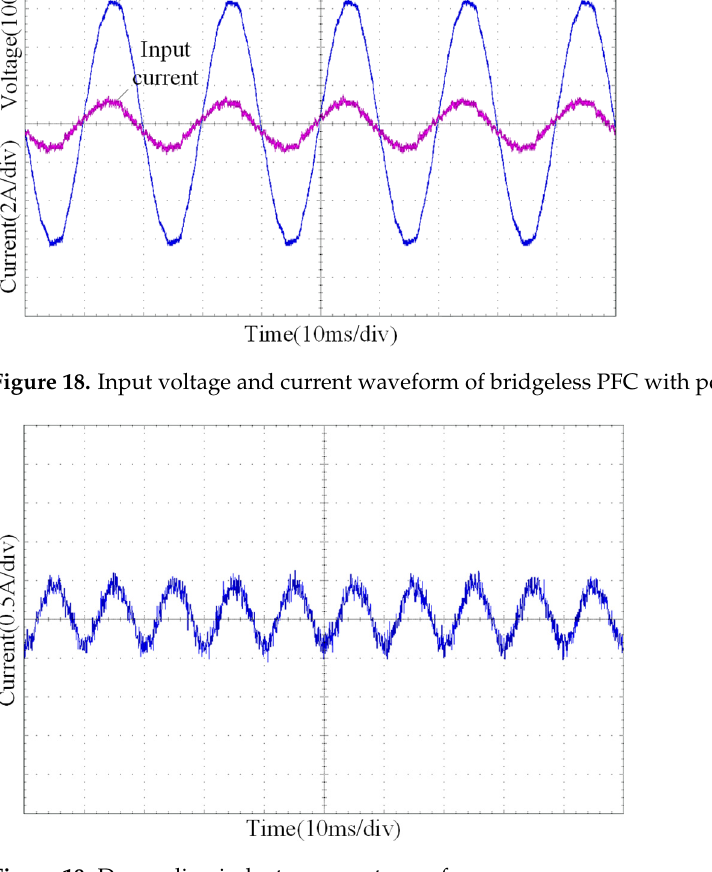
Figure 19. Decoupling inductor current waveform.